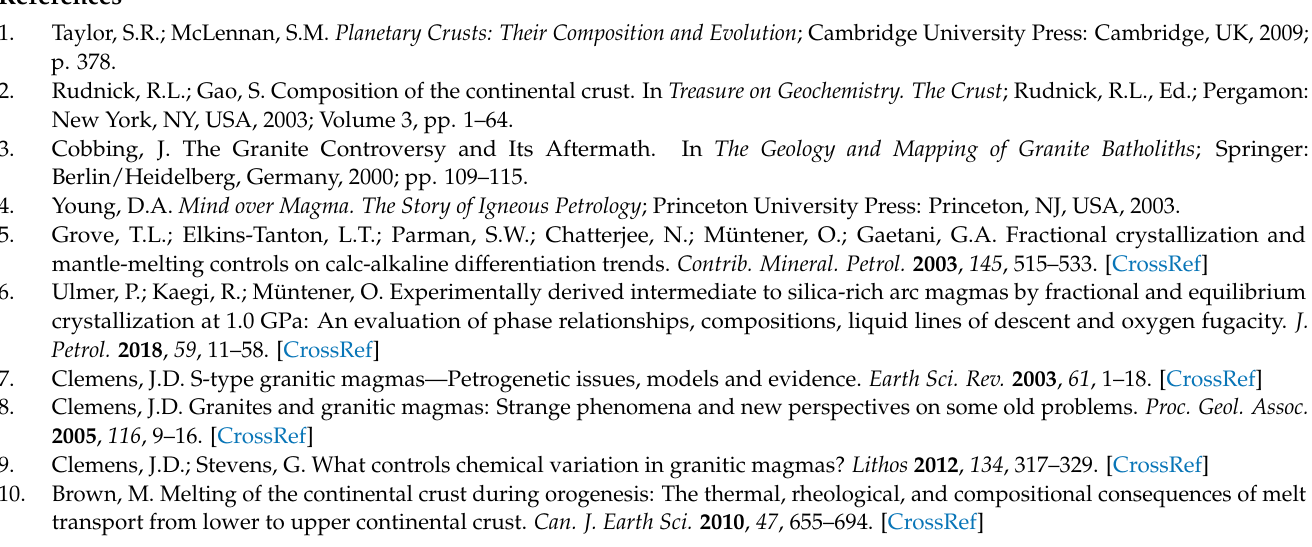
Table S2: Statistical evaluation of the data. Shown here the mean, standard deviation (1 sigma) and the mean square error, Table S3: Statistical analysis using the Mann-Whitney U pairwise test with Bonferroni correction (Past 4.01). Medians of the Th/U ratios differ significantly for all granite types on the 95% confidence interval, with the exception of the S-I-type and I-type medians, which only differ on the 90% confidence interval. U concentrations differ significantly for all granite types except the S-I-type and A-type granites. Th concentrations differ significantly for all granite types on the 95% confidence